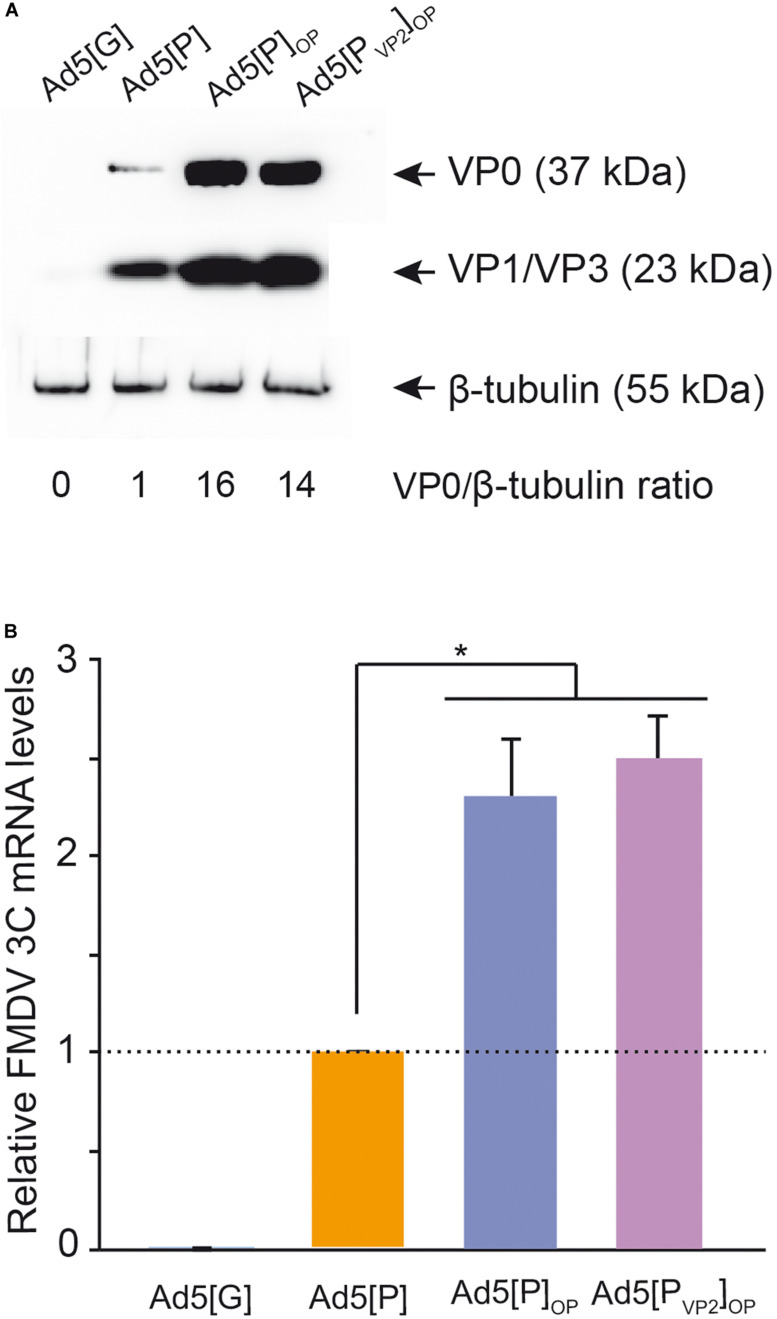
Analysis of foot-and-mouth disease virus (FMDV) capsid protein expression. Lysates of human embryonic kidney (HEK) 293A cells infected with Ad5[P], Ad5[P]OP, or Ad5[PVP2]OP were analyzed by SDS-PAGE and Western blot using FMDV anti-O1/Campos polyclonal serum (A). An Ad5 encoding an irrelevant antigen (green fluorescent protein), Ad5[G], was also included. To estimate FMDV structural protein accumulation, the ratios of VP0 to β-tubulin bands were calculated and normalized to the Ad5[P] VP0/β-tubulin ratio, set at 1.0. Mean values from two independent experiments are presented. Standard deviations ranged from 0% to 2% (not shown). VP0, VP1/VP3, and β-tubulin are indicated with an arrow. (B) Analysis of 3C mRNA expression in HEK 293A cells infected with Ad5[G], Ad5[P], Ad5[P]OP, or Ad5[PVP2]OP by quantitative real-time PCR. HEK 293A cells were infected with the corresponding Ad5 vector at multiplicity of infection (MOI) 5. Twenty-four hours post-infection, total RNA was isolated and used to amplify a fragment of the FMDV 3Cpro open reading frame (ORF) and, as a control, a fragment of human Actin ORF by RT-qPCR. For each experimental group, the FMDV 3Cpro transcript level relative to the Ad5[P] group was calculated by using the 2− ΔΔCt equation. Data correspond to the average and standard deviation from two independent experiments. *p < 0.01 (ANOVA).